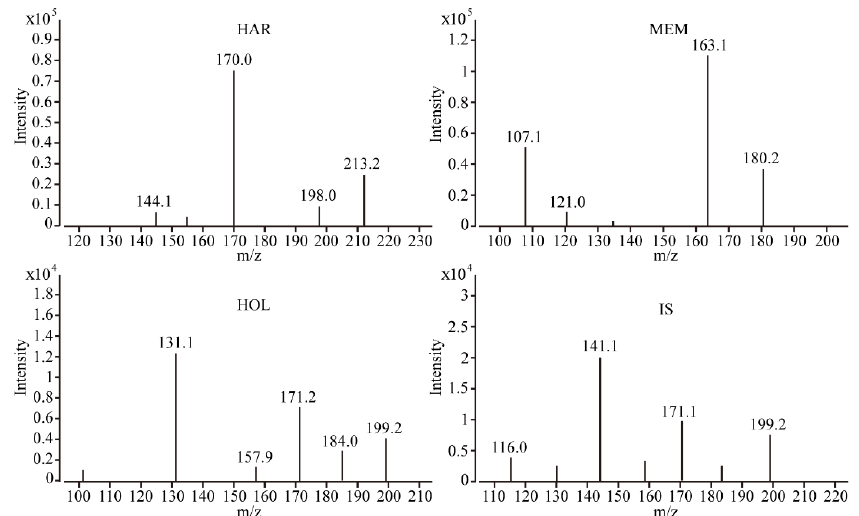
Figure 2. Product ion mass spectra of harmine (HAR), memantine (MEM), harmol (HOL) and tacrine (IS).